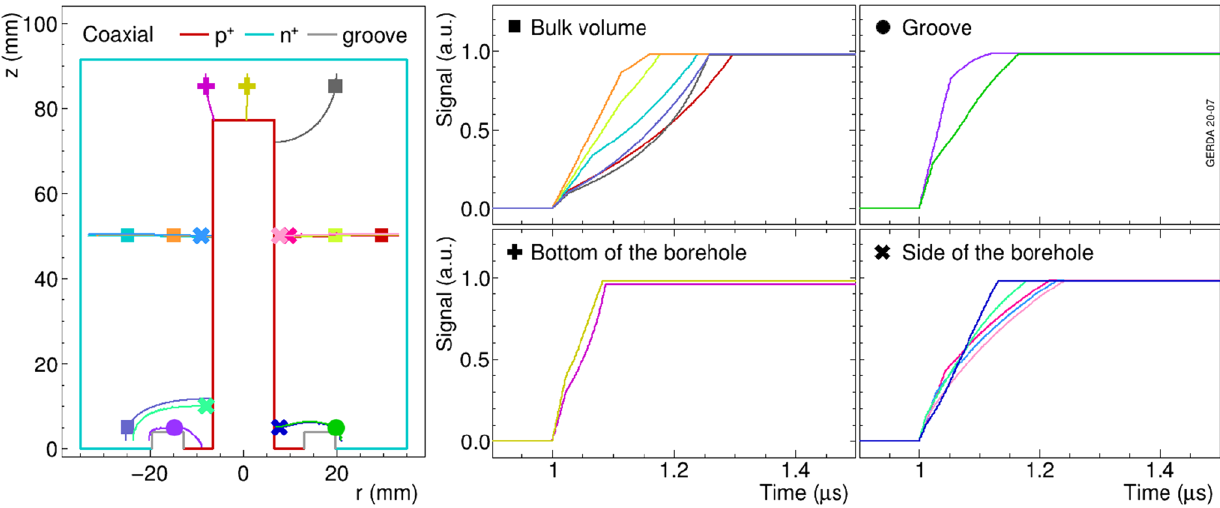
Fig. 3 Simulated charge pulses in indicated parts (bulk, groove, bottom/side of borehole) of a typical coaxial detector. The electronic response of the readout chain and noise are not included